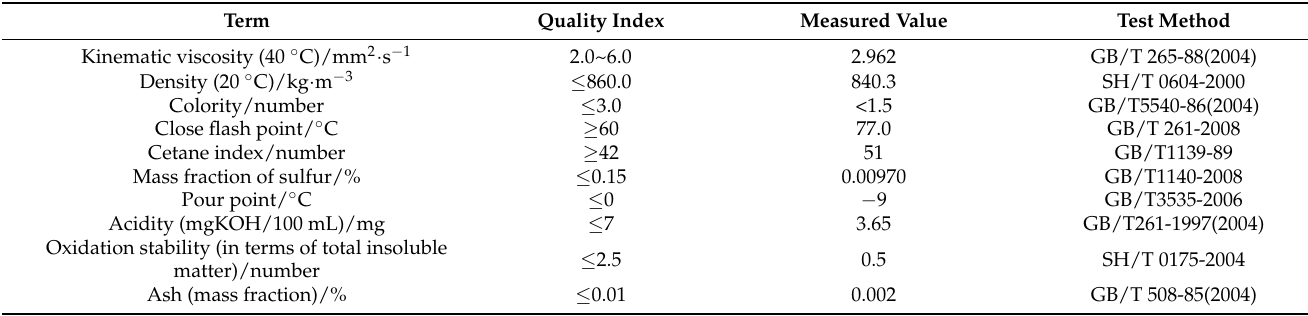
Table 3. Properties of engine fuel